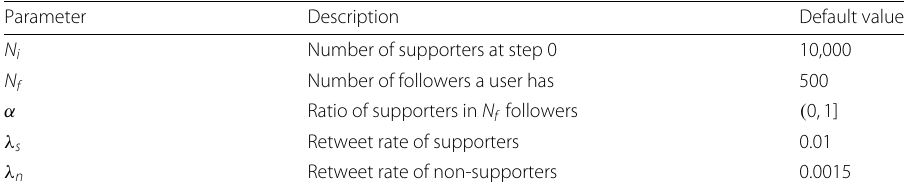
Table 1 Parameter values in the model